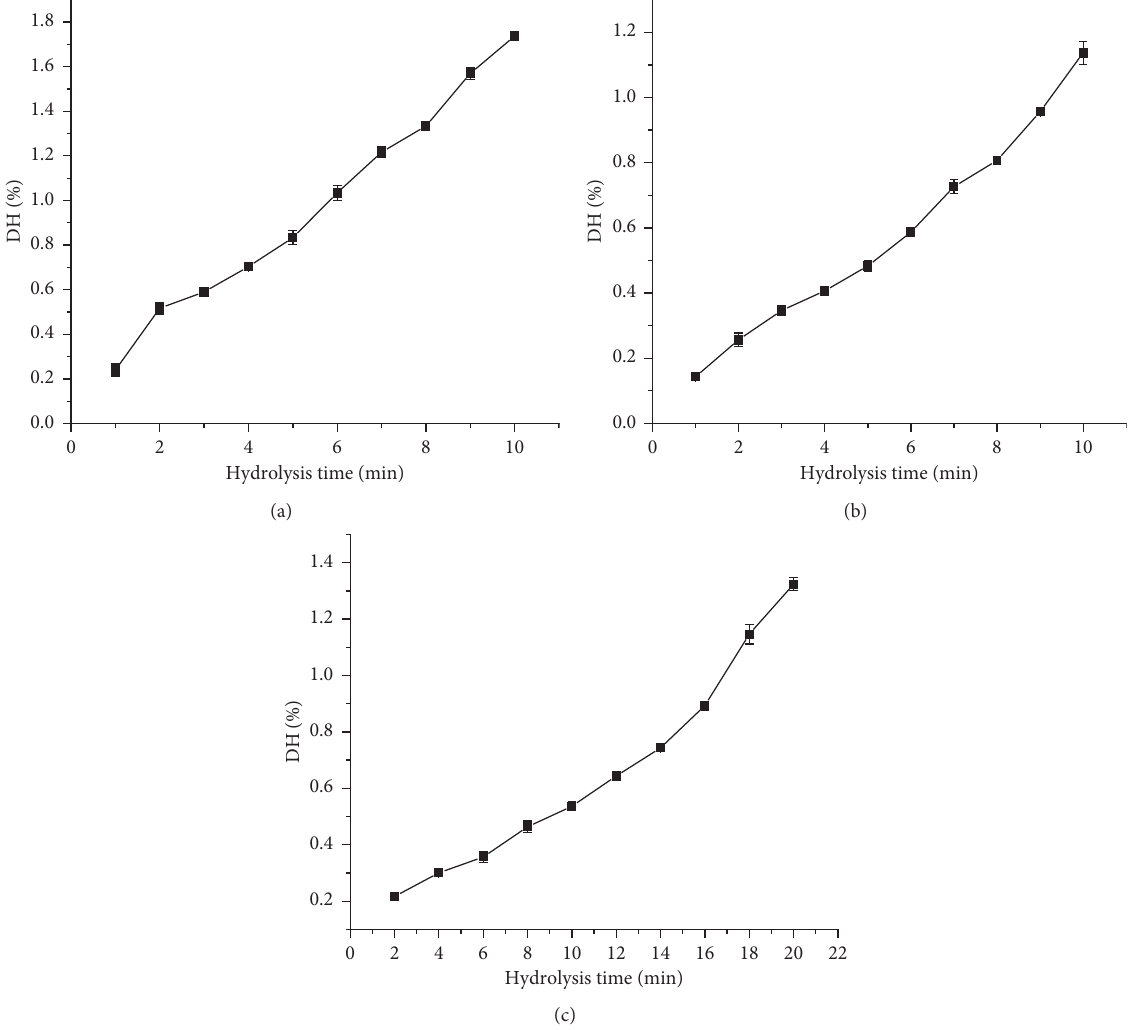
Figure 1: The effect of time on the degree of hydrolysis of SPI: (a) papain; (b) neutral protease; (c)